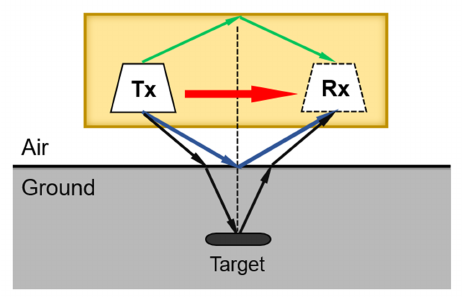
Figure 1. The prototype of the GPR transceiver